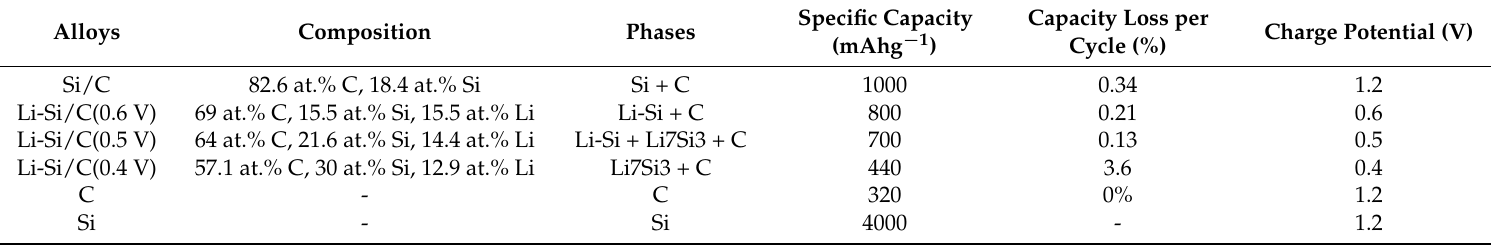
Table 1. The theoretical specific capacity with Li-Si–C composite based on different Li-Si alloy